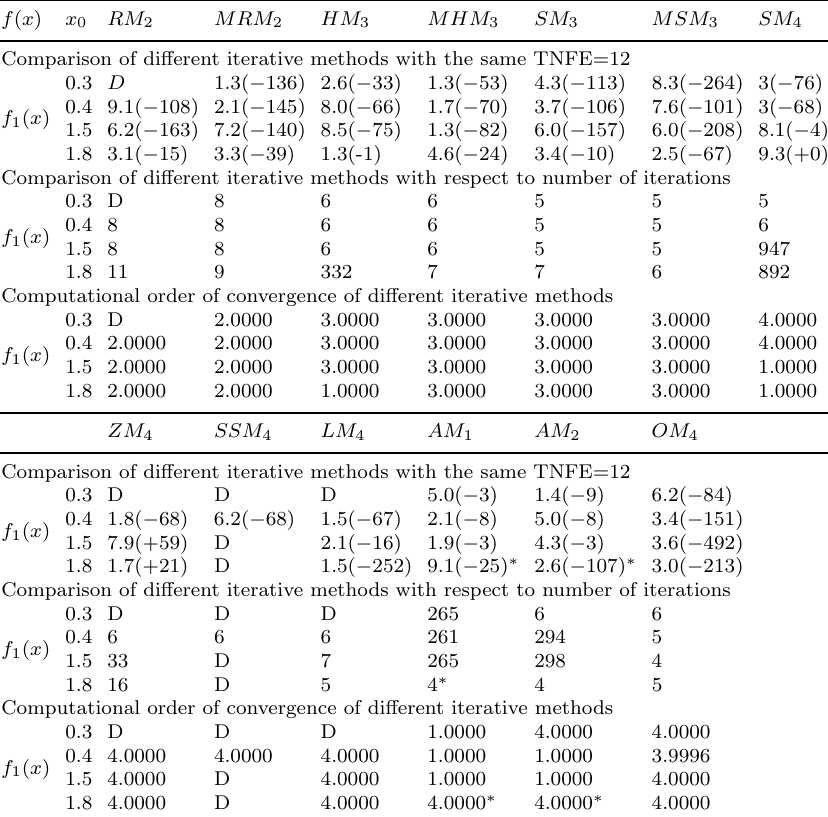
Table 3. Test problem